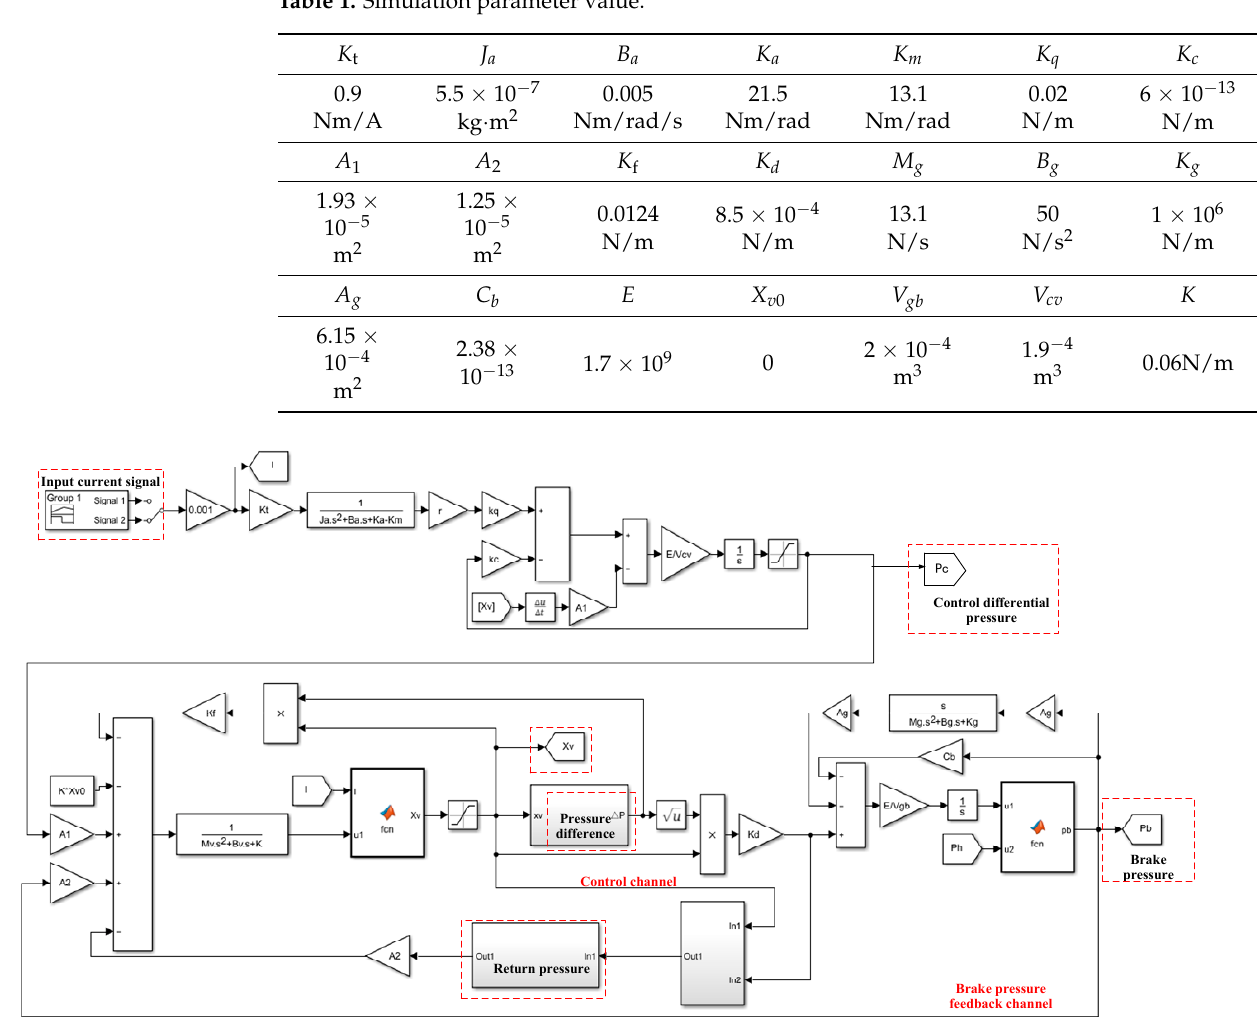
Figure 7. The MATLAB/Simulink model of new brake pressure servo valve-actuator system. The current signal is input to the pilot stage of servo valve. In addition, the control pressure is input to A 2 through the feedback channel, and ∆ P is obtained through Formula (13). Then the output displacement X V of the main spool is obtained according to Formulas (5) and (6). ∆ P and X V are input to the actuator together, then the output pressure P b